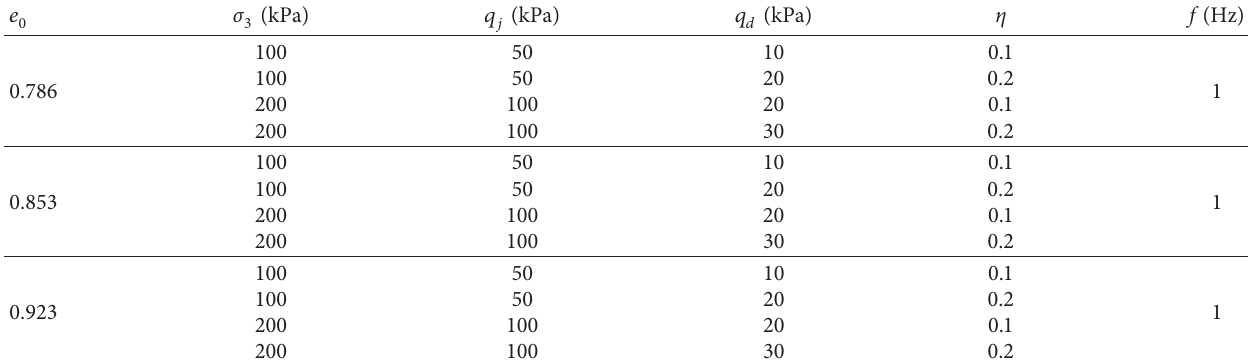
Table 3: Experimental schemes for simple loading and